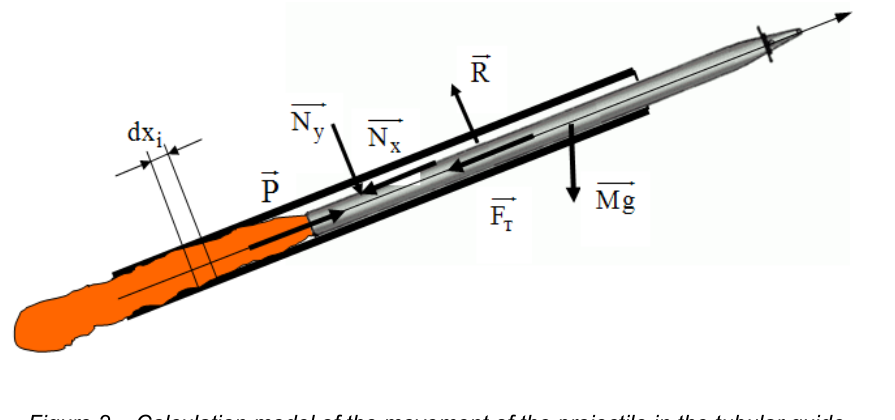
Figure 2 – Calculation model of the movement of the projectile in the tubular guide Рис . 2 – Расчетная модель движения снаряда в трубчатой направляющей Слика 2 – Модел прорачуна кретања пројектила у лансирној